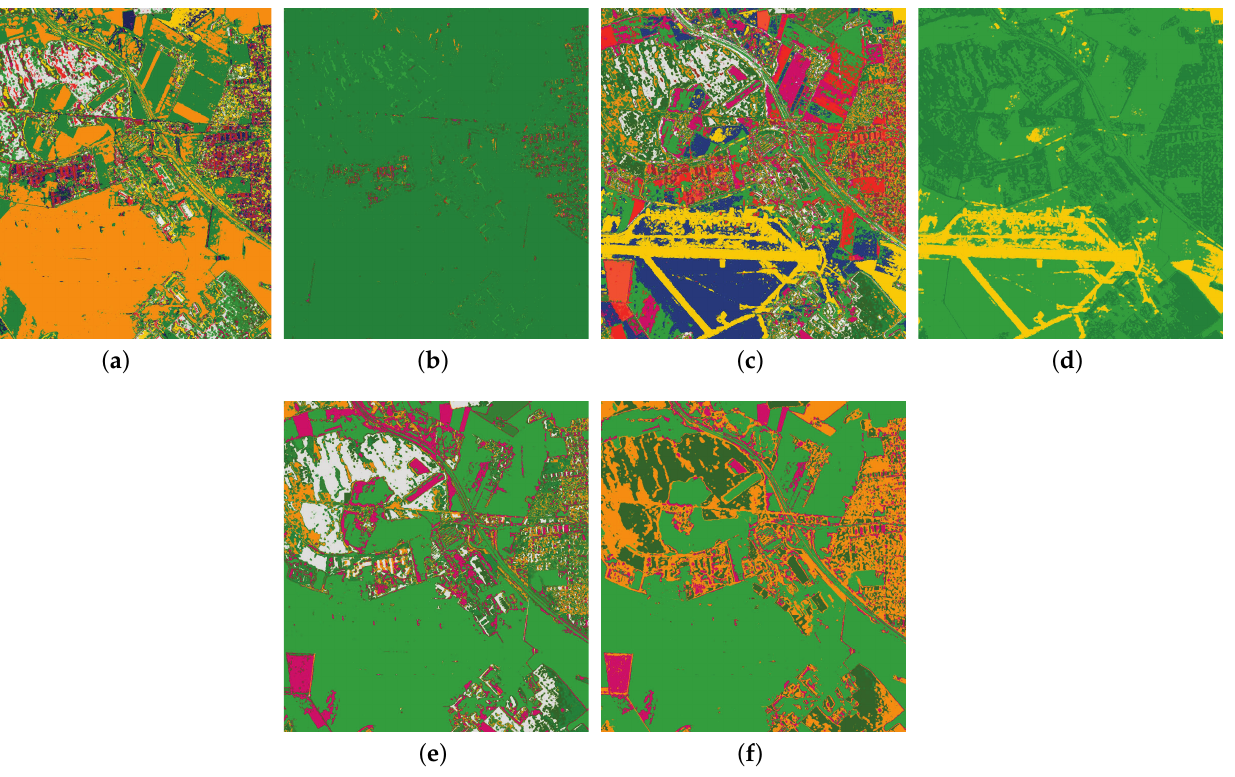
Figure A5. Classification results with different distance thresholds. ( a ) Result with distance threshold 0.5%. ( b ) Result with distance threshold 1.0%. ( c ) Result with distance threshold 1.5%. ( d ) Result with distance threshold 2.0%.